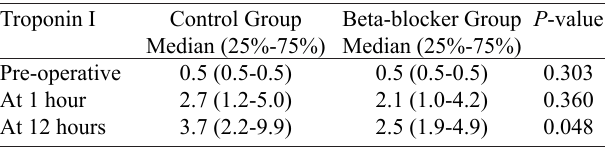
Table 4. Analysis of troponin I results (ng/ml) in both